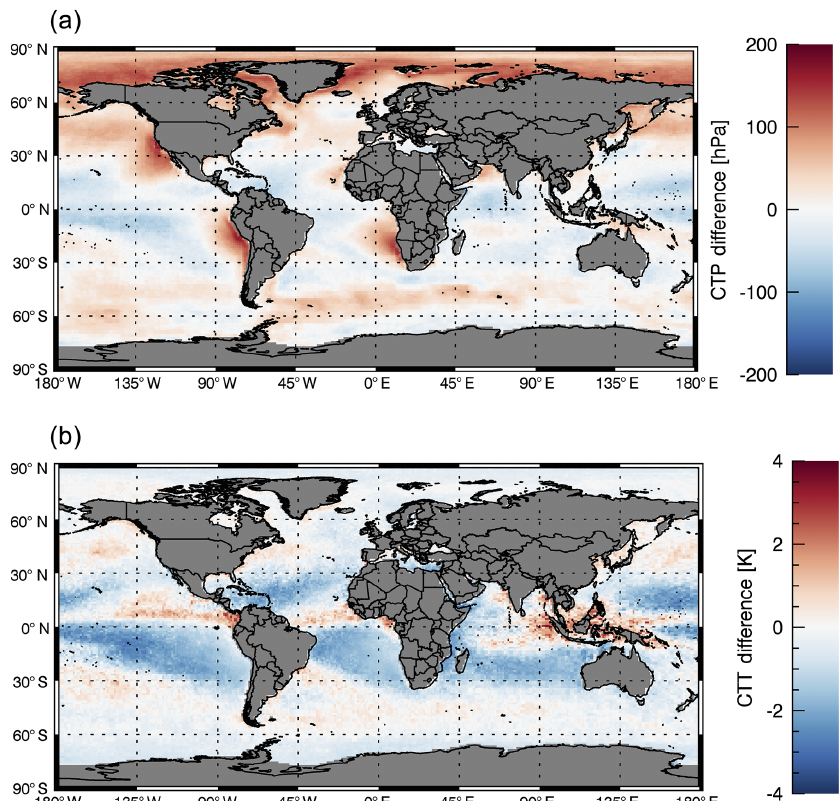
Figure 4. Cloud-top pressure (a) and temperature (b) differences between aggregated 1km resolution C6 and 5km resolution C5.1 for the common pixel